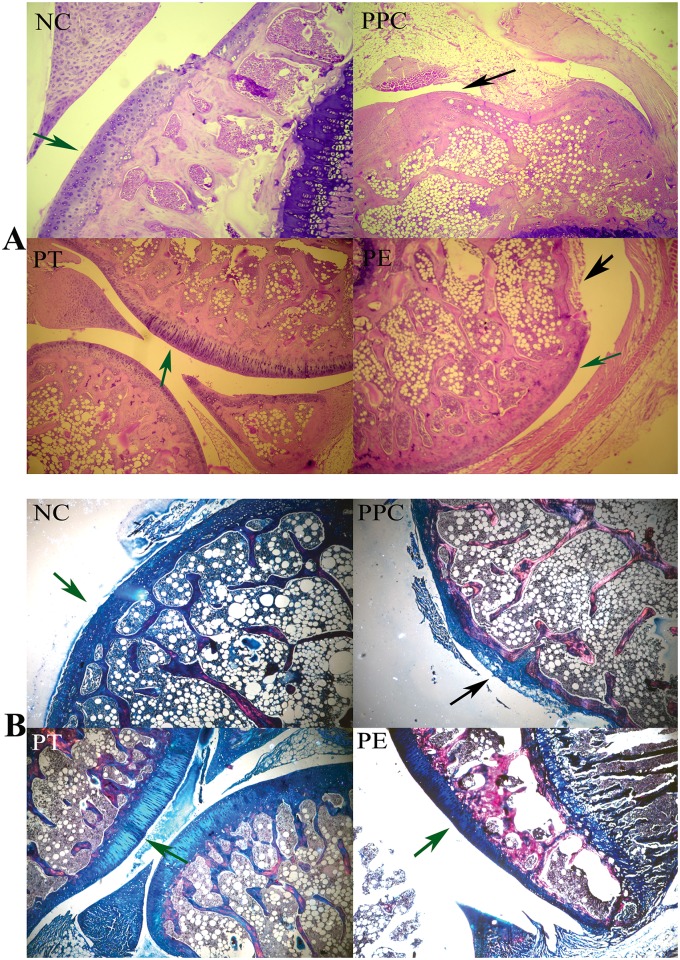
Effect of prophylactic treatment of polyphenols on collagen-induced arthritis (CIA).(A) Hematoxylin and Eosin-stained sections and (B) Masson's Trichrome stained sections of tibiofemoral joints of rats; NC indicates Negative Control (i.e., normal joint without induction and treatment); remaining illustrations are from CIA joints: PPC—Prophylactic Positive Control; PE—Prophylactic EGCG; and PT—Prophylactic TA; (black arrow = disintegrated cartilage; green arrows = intact cartilage)